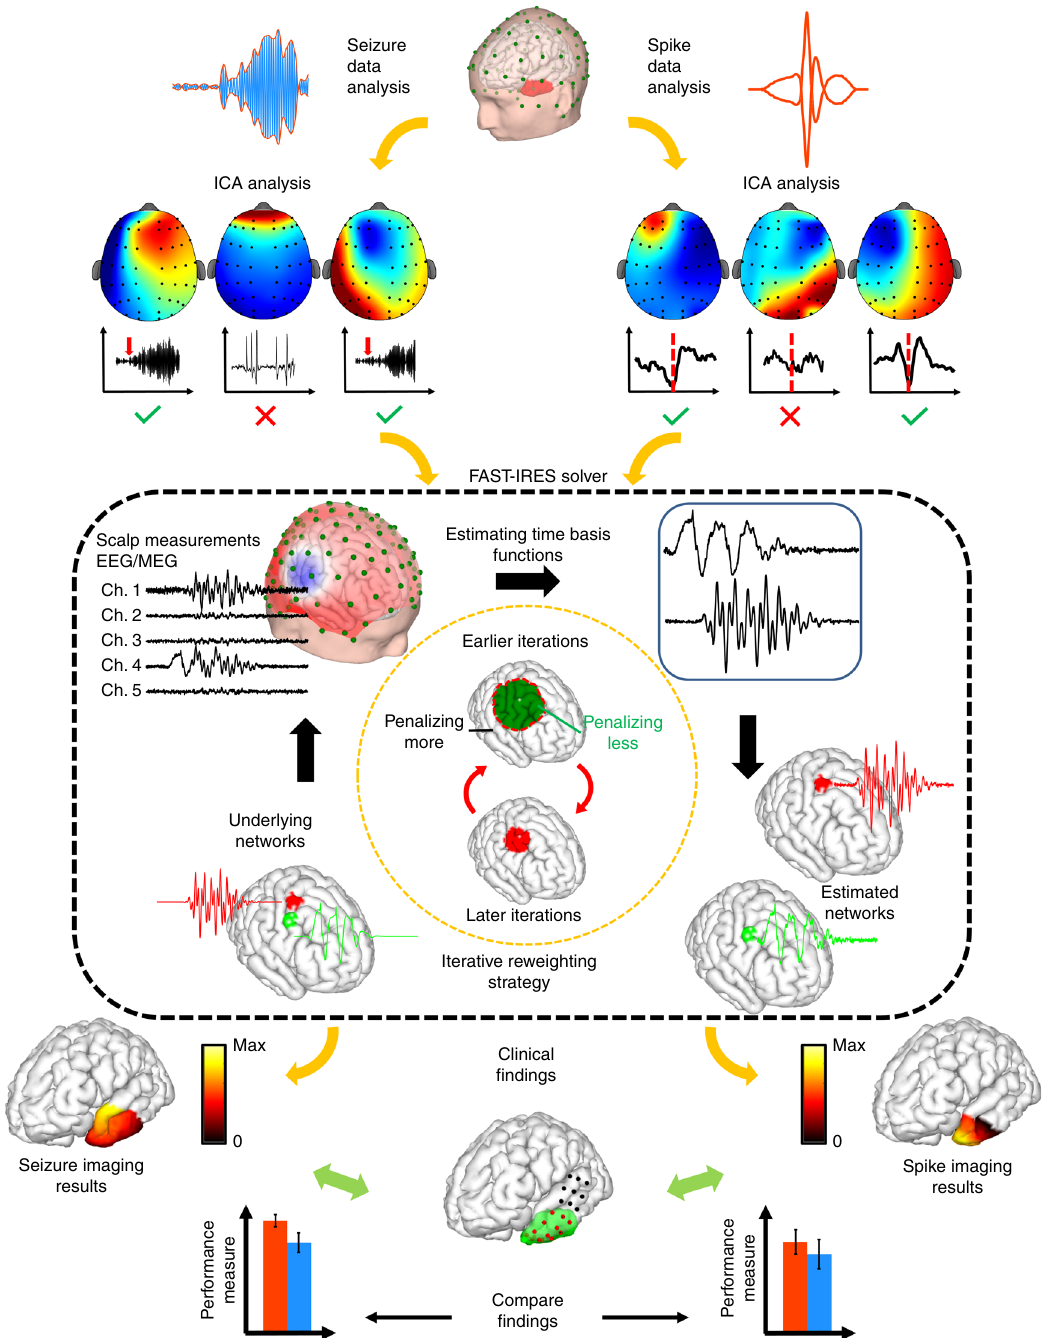
Fig. 3 Overall study design. In this fi gure the analysis pipeline is depicted. (Top) The main two arms of the study show how interictal spikes and seizures are extracted from EEG recordings, denoised, their time basis function determined, and input into the FAST-IRES solver. (Middle) The proposed FAST-IRES source imaging approach takes the spatial extent and focality of brain sources into account. The output of the algorithm is a spatiotemporal distribution of underlying brain sources, from which the epileptogenic zone (EZ) is extracted and compared to clinical fi ndings, such as resection volume and seizure onset zone determined from intracranial EEG. (Bottom) Finally, the performance of epilepsy features, i.e. estimating the EZ by imaging interictal activity and ictal activity with FAST-IRES, is evaluated by comparing the estimated EZ to clinical fi